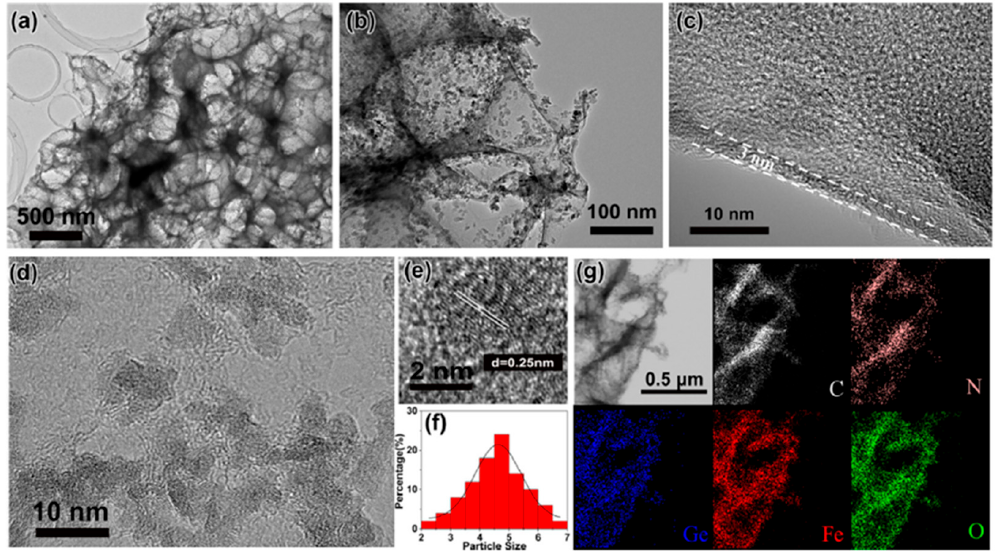
Figure 11. ( a , b ) TEM and ( c – e ) HRTEM images of 3D GFO/N-CNSs; ( f ) size distribution diagram of GFO nanodots; ( g ) EDS mapping of the elements of 3D GFO/N-CNSs [31]. Reproduced with permission, Copyright Elsevier 2018.